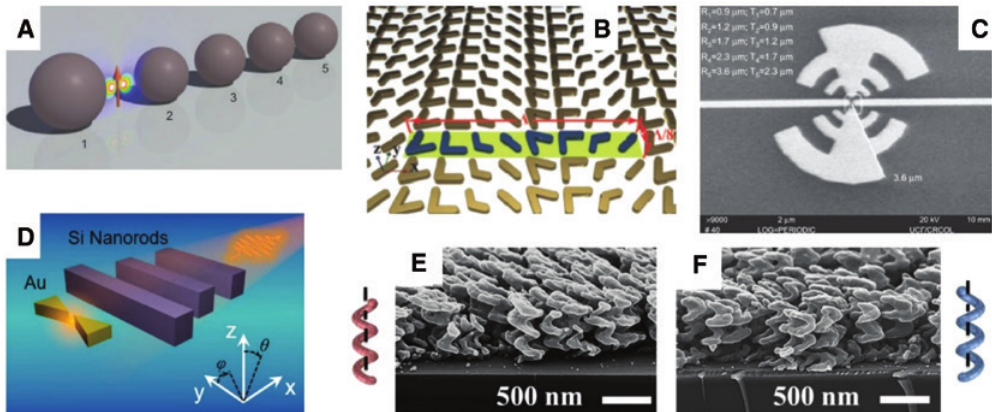
Figure 1: Examples of 2D and 3D nanostructures designed for nanophotonics applications. Designs of nanoantennas based on nanoparticles (A) and V-shaped (B) structures. Optical antenna coupled to a microbolometer (C). Design of a hybrid Au-Si Yagi-Uda nanoantenna (D). Left- (E) and right- (F) handed arrays of silver nanospirals. (A–C) Reprinted with permission from Ref. [16]. (D) Reprinted with permission from Ref. [17]. (E) and (F) Reprinted with permission from Ref.